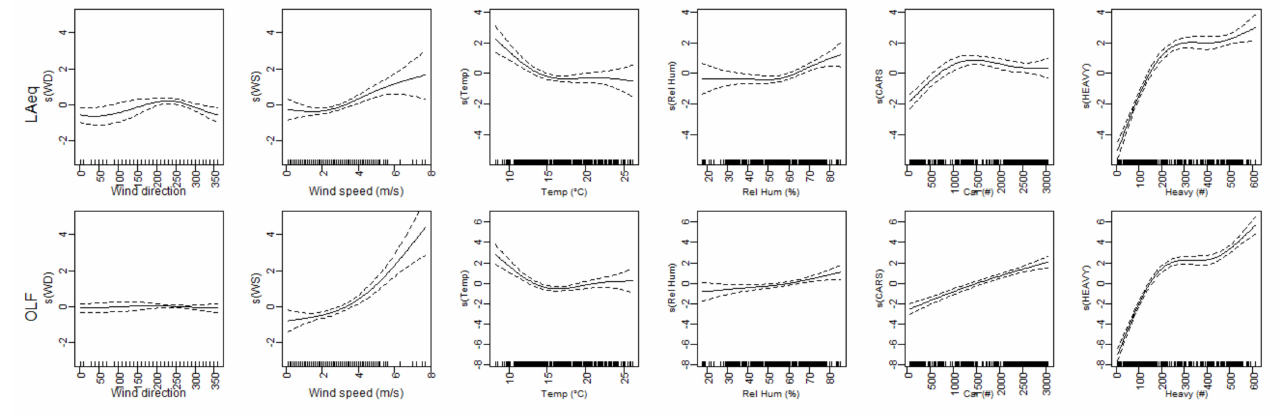
Figure 5. Two GAM models for the noise parameters: L Aeq , OLF, including temperature and relative